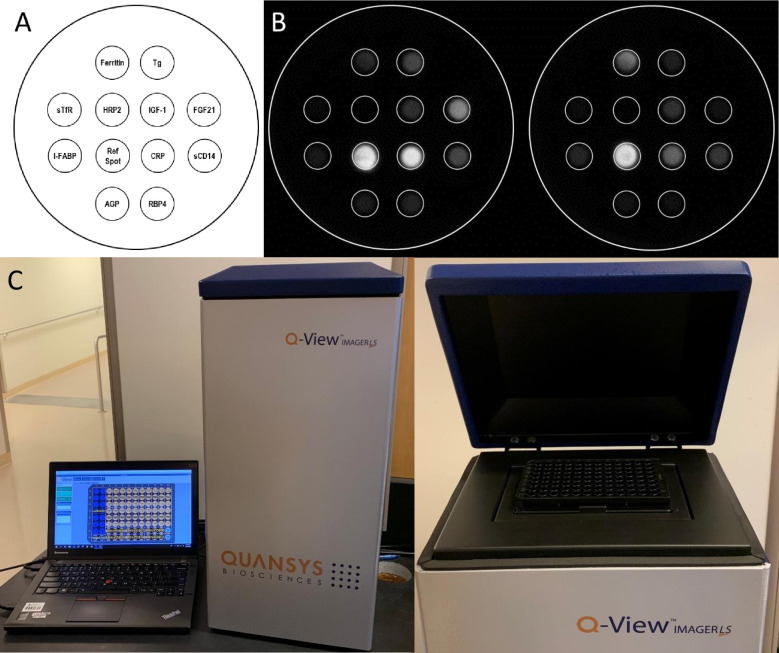
The 11-plex Micronutrient and EED Assessment Tool.(A) Schematic of placement of assays in each test well. (B) Images of developed signal in wells of a MEEDAT plate, with varying concentration of each analyte. (C) Images of Q-View Imager LS in use.